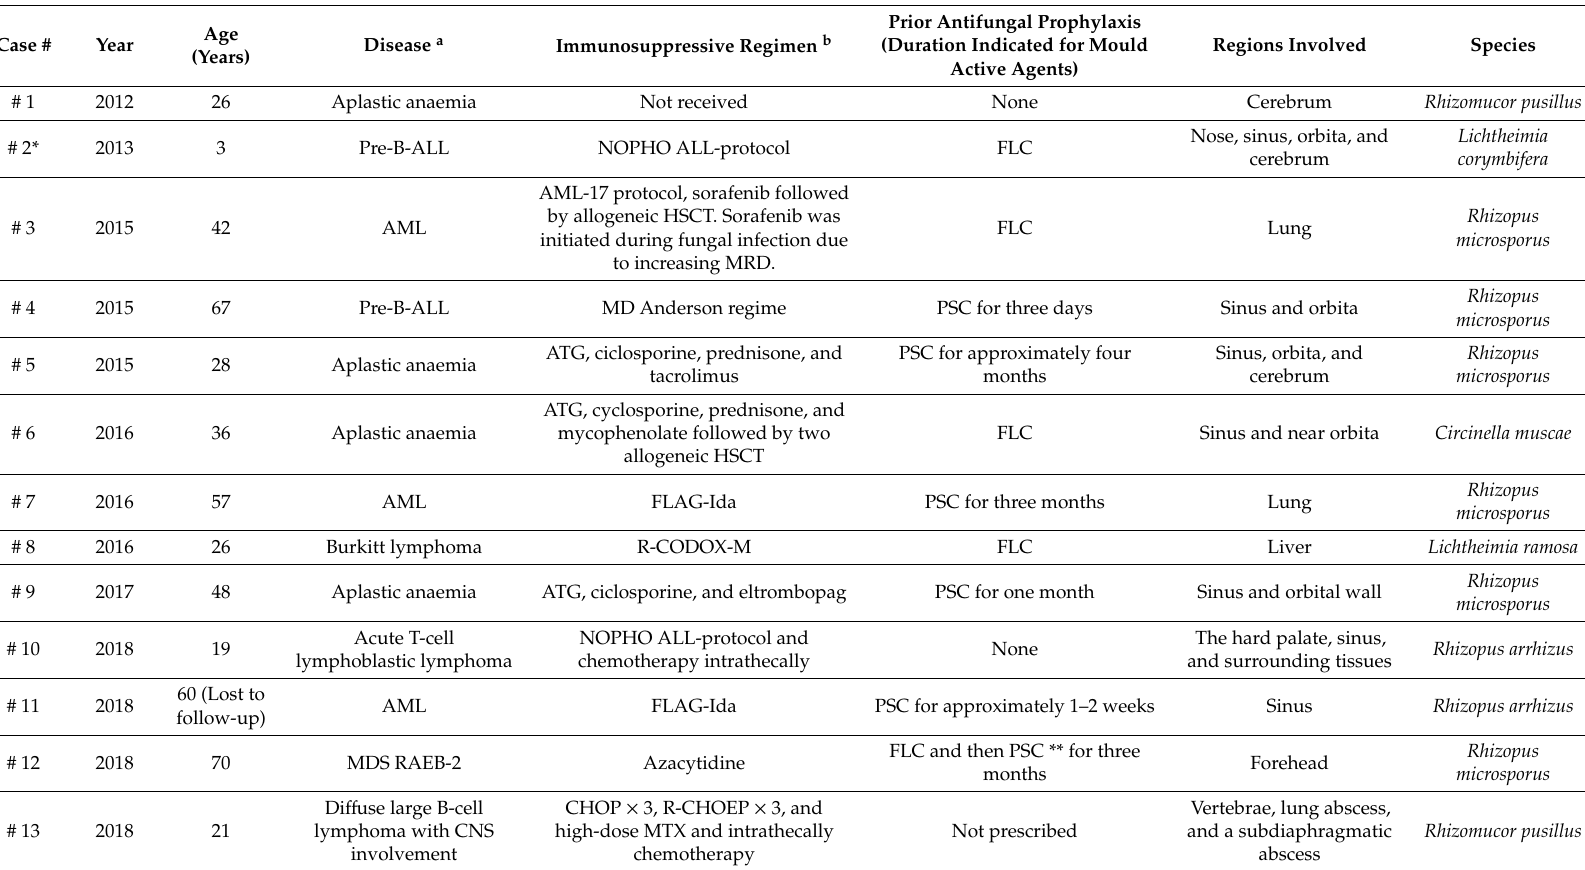
Table 1. Baseline clinical characteristics of the 13 patients at the time of diagnosis of the Mucorales